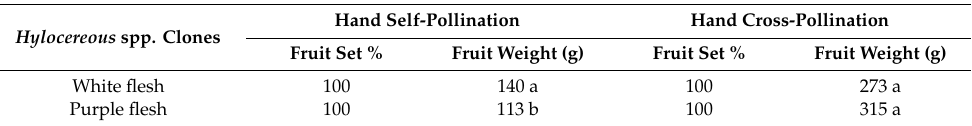
Table 3. Effect of pollination method on fruit set percentage (%) and fruit weight (g) in the two Hylocereous spp. clones grown in greenhouse in Italy. Hand Self-Pollination Hand Cross-Pollination Hylocereous spp. Clones Fruit Set % Fruit Weight (g) Fruit Set % Fruit Weight (g) White flesh 100 140 a 100 273 a Purple flesh 100 113 b 100 315 a Values represent means ( n = 6–7) fruits per treatment. Within rows, mean values followed by the same letter do not differ significantly ( p < 0.05). Student’s t -test was used to compute the pair-wise comparisons between group